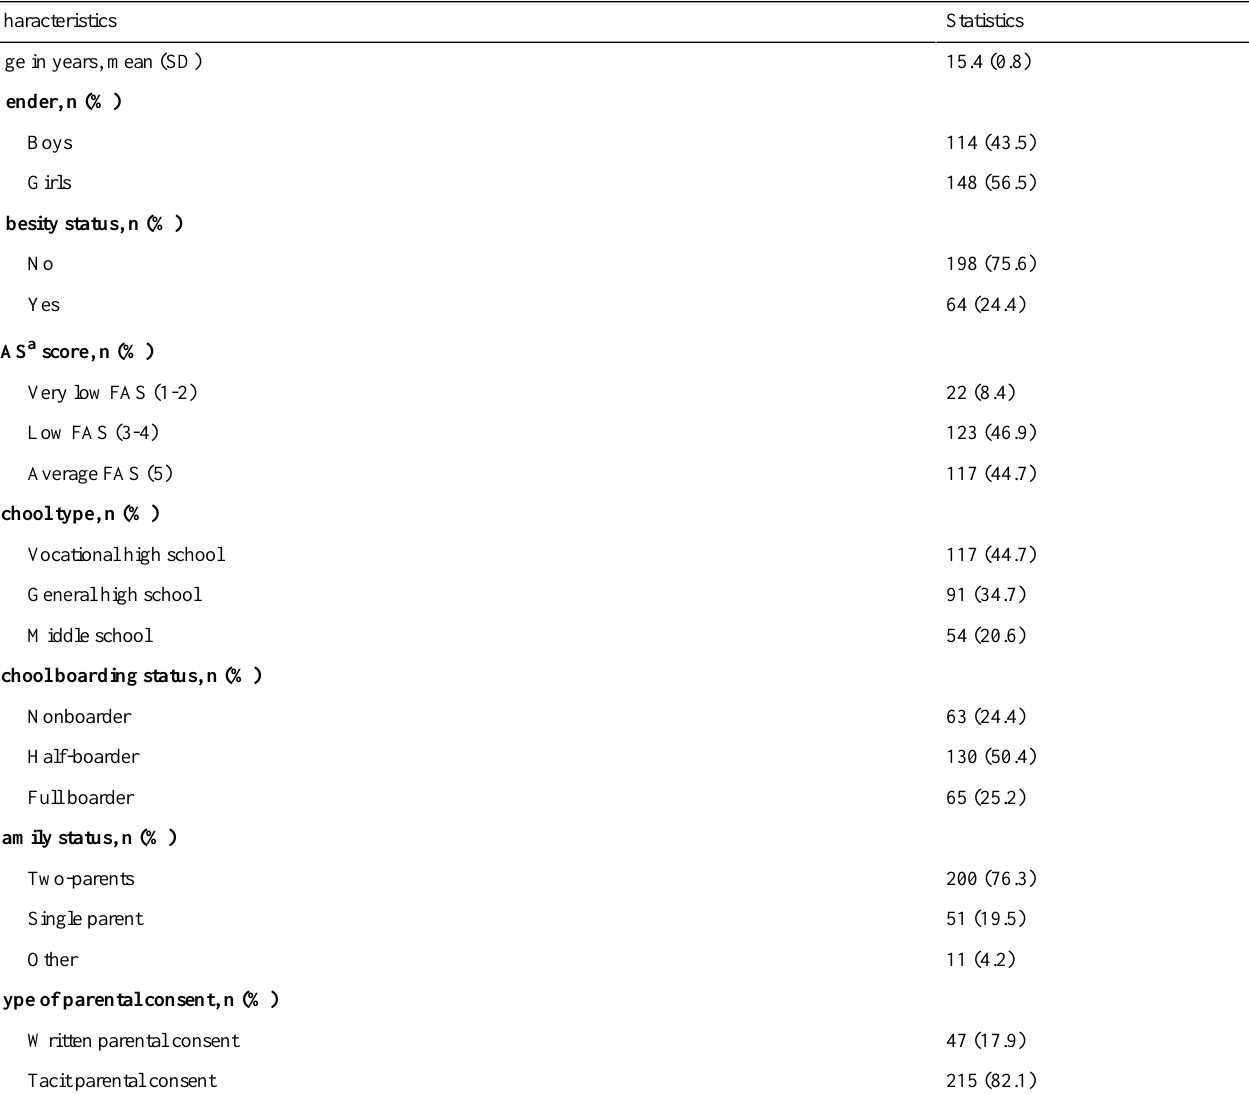
Table 1. Sociodemographic characteristics of the study sample (N=262).